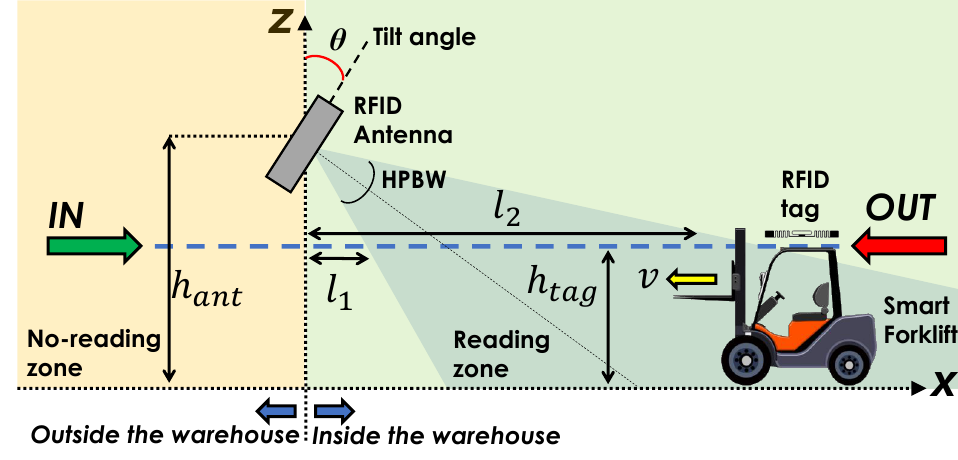
Figure 10. Sketch of the asymmetrical